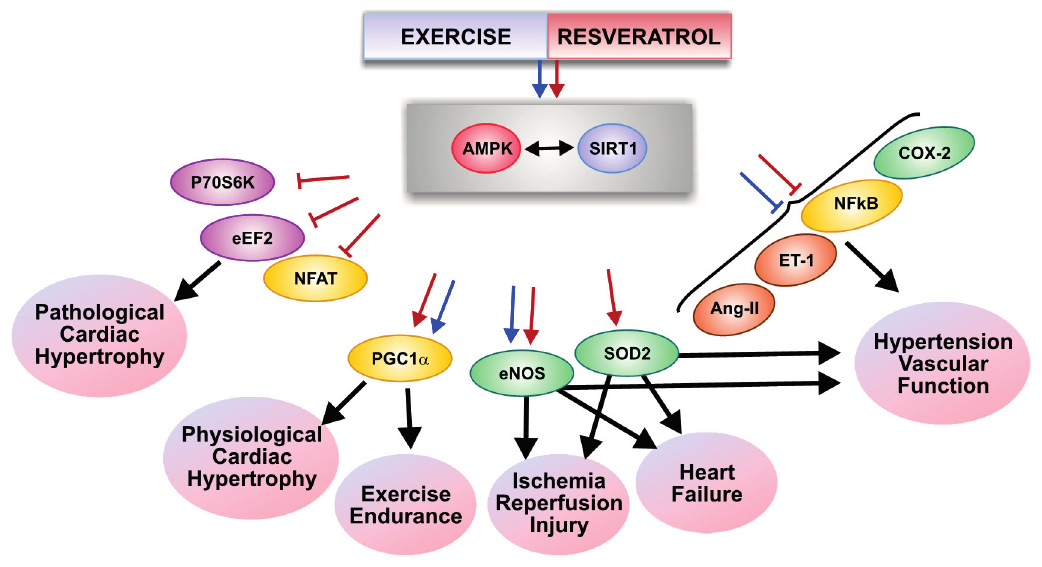
Figure 1. Molecular pathways regulated by exercise training and resveratrol in the heart, skeletal muscle and vasculature. Blue arrows/lines indicate molecular pathways activated by exercise and red arrows/lines indicate molecular pathways activated by resveratrol. AMPK, AMP-activated protein kinase; Ang-II, angiotensin-II; COX-2, cyclooxygenase-2; eEF2, eukaryotic elongation factor2; eNOS, endothelial nitric oxide synthase; ET-1, endothelin-1; NFAT, nuclear factor of activated T-cells; NFkB, nuclear factor kB; p70S6K, p70 S6 kinase; PGC1 α , peroxisome proliferator activated receptor gamma coactivator; SIRT1, sirtuin-1; SOD2, superoxide